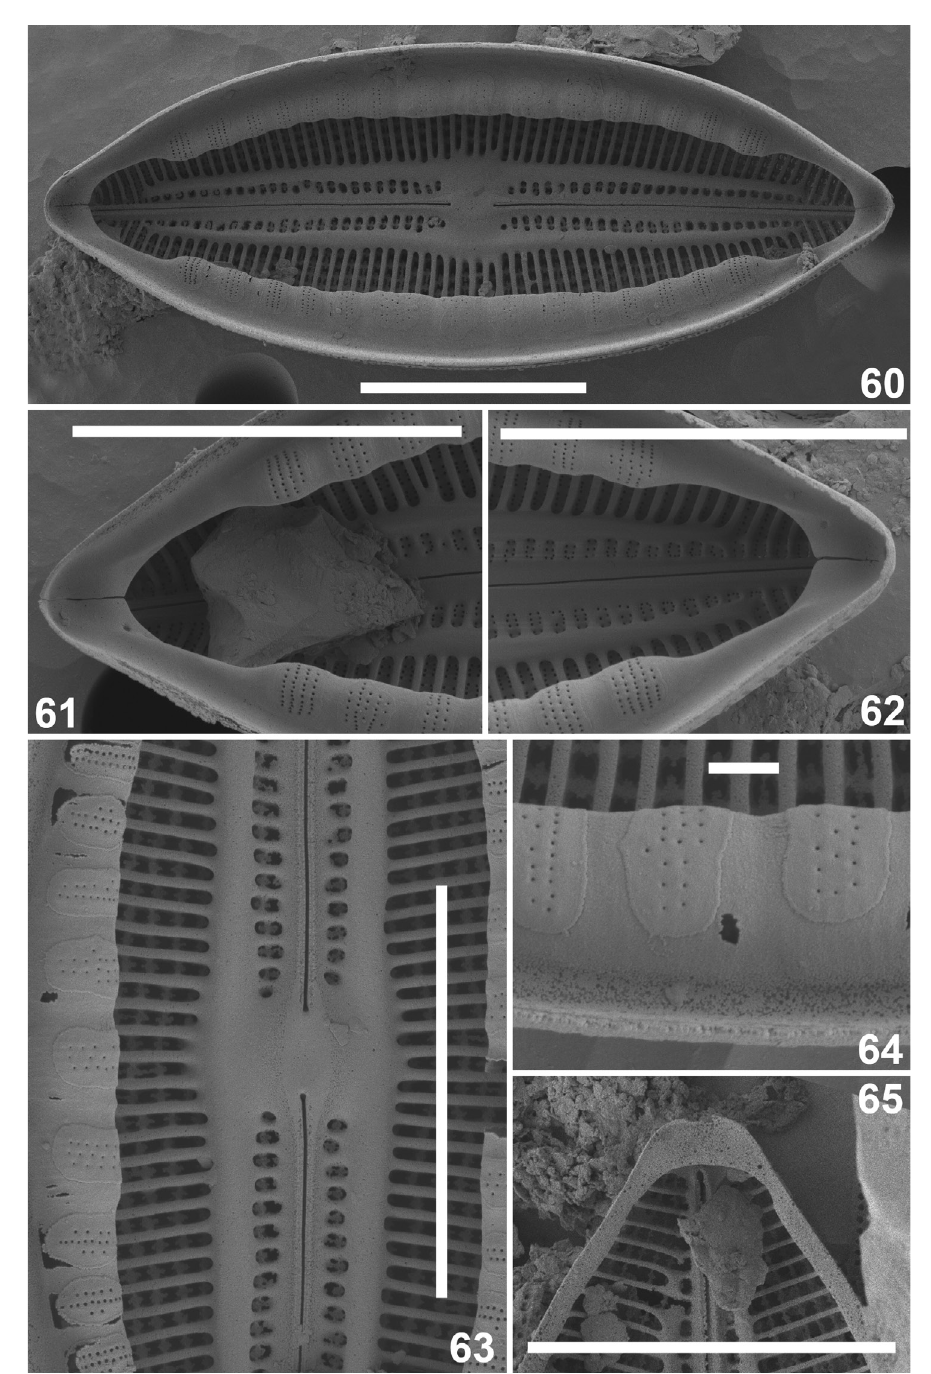
Figs 60–65. Mastogloia senegalensis Van de Vijver, Fofana, Sow & Ector sp. nov. Scanning electron micrographs (SEM) of valves from the Lac de Guiers type population ( Van de Vijver sample SEN-42 ). 60 . SEM internal view of an entire valve with the partectal ring. 61–62 . SEM internal details of the partectal ring near the valve apices showing the cleft on each apex. 63 . SEM internal detail of the central area and part of the partectal ring. 64 . SEM internal detail of the partecta showing the partectal walls with 2–4 series of small, rounded pores loosely aggregated in distinct plaques. 65 . SEM internal view of a valve apex without the partectal ring (note the small pseudoseptum). Scale bars: 60–63, 65 = 10 µm; 64 = 1